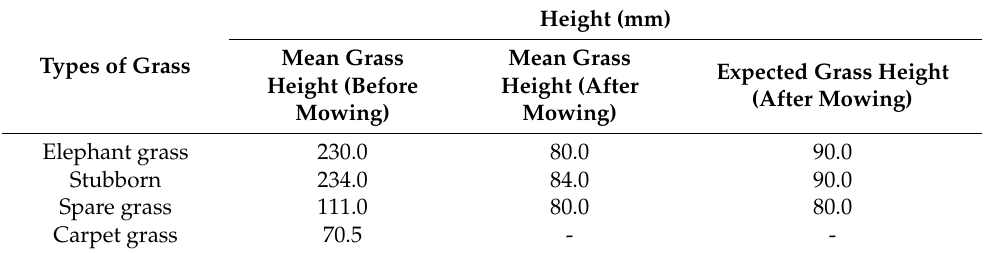
Table 1. Calculated results on grass height for different types of grass before and after mowing [26]. Height (mm) Mean Grass Mean Grass Types of Grass Expected Grass Height Height (After Height (Before (After Mowing) Mowing) Mowing) Elephant grass 230.0 80.0 90.0 Stubborn 234.0 84.0 90.0 Spare grass 111.0 80.0 80.0 Carpet grass 70.5 -